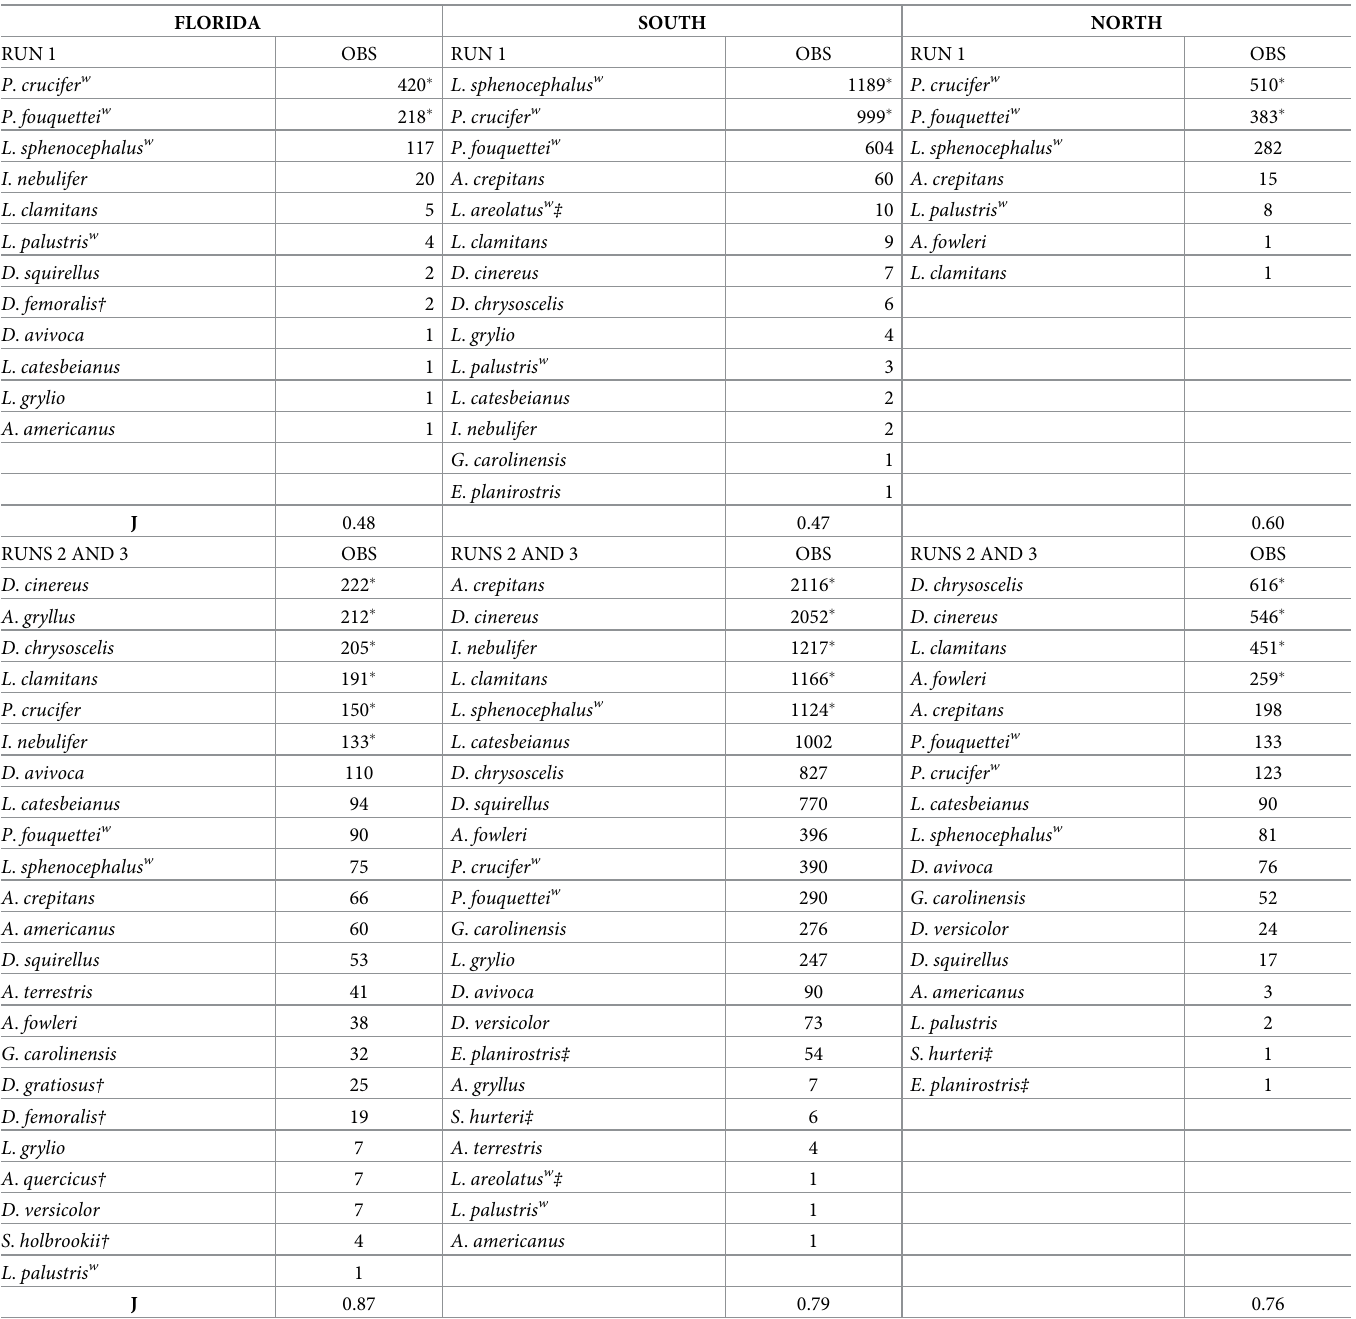
Table 6. Number of observations by region and